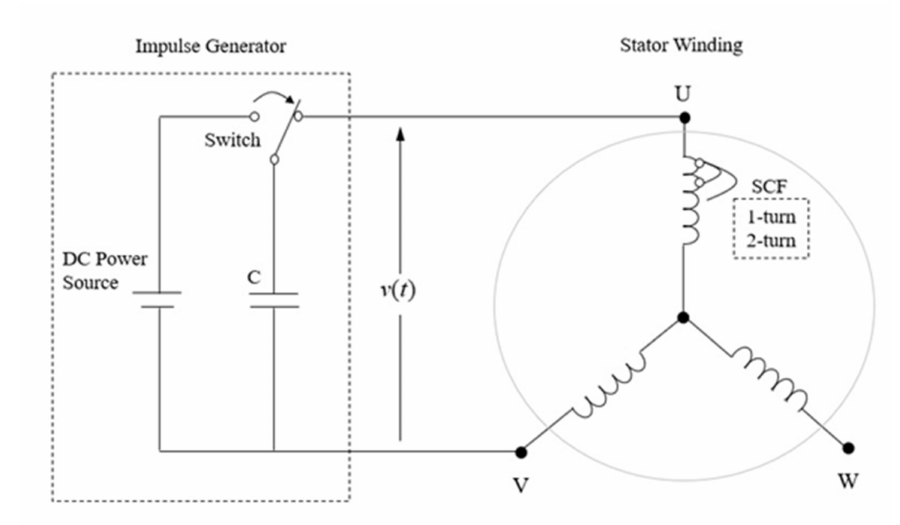
Figure 1. Experimental setup of impulse